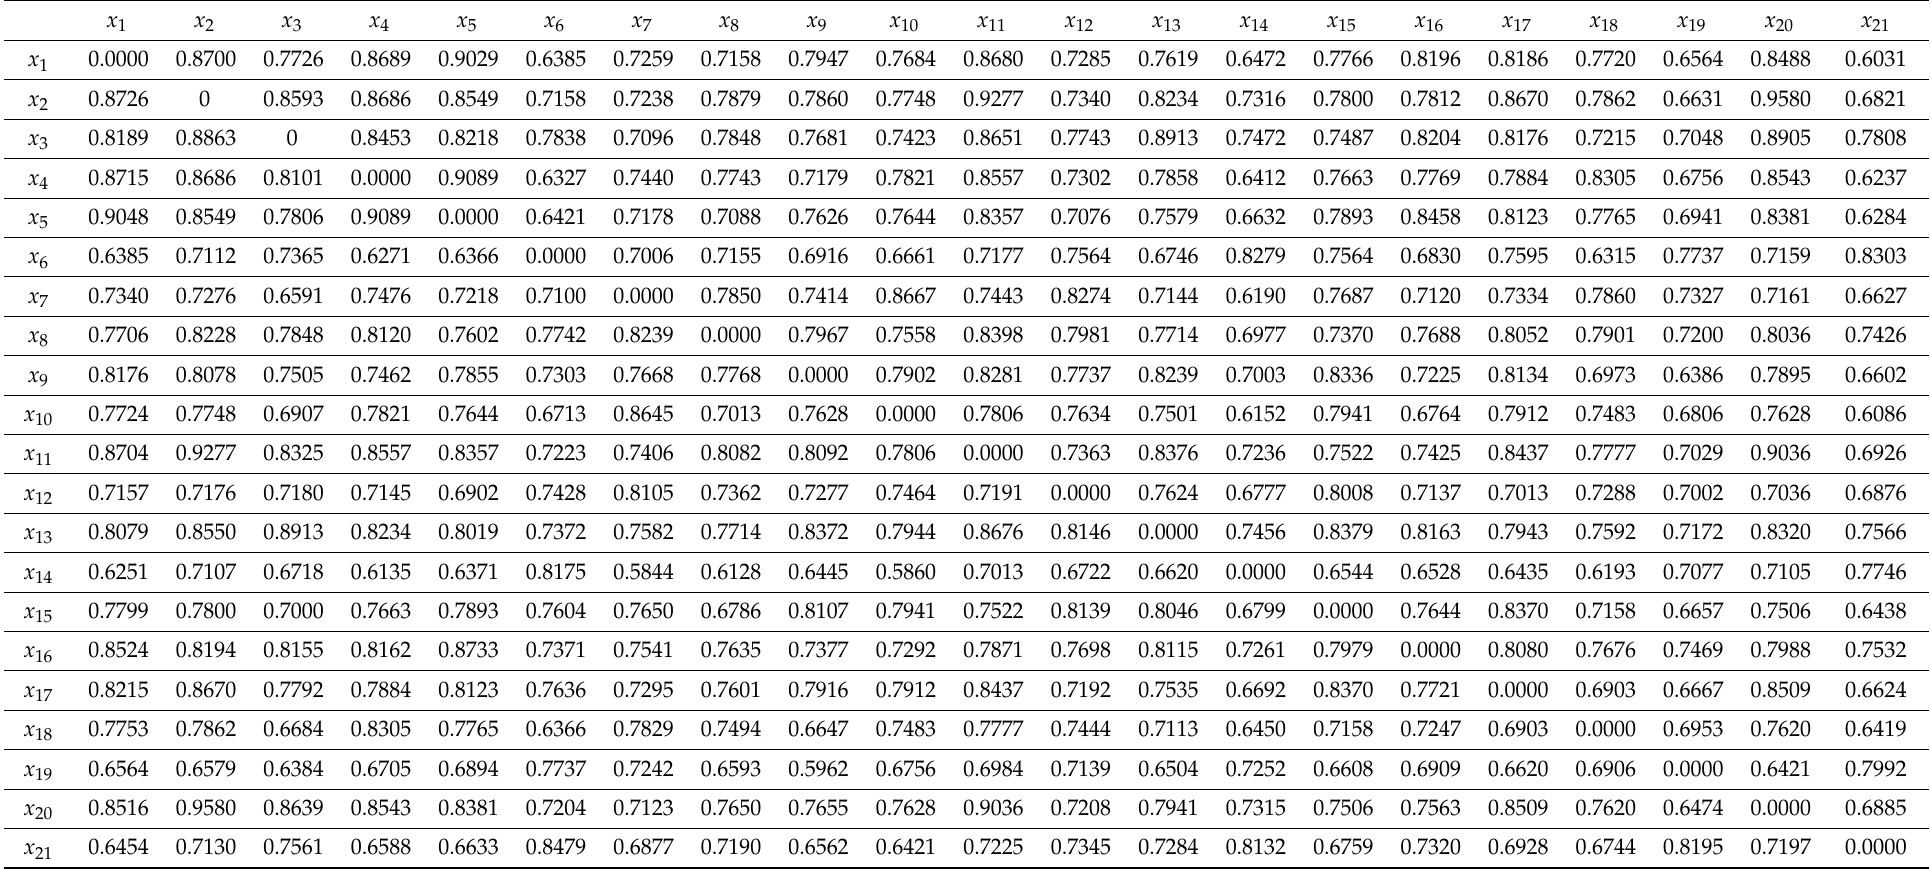
Table A2. The initial direct influence